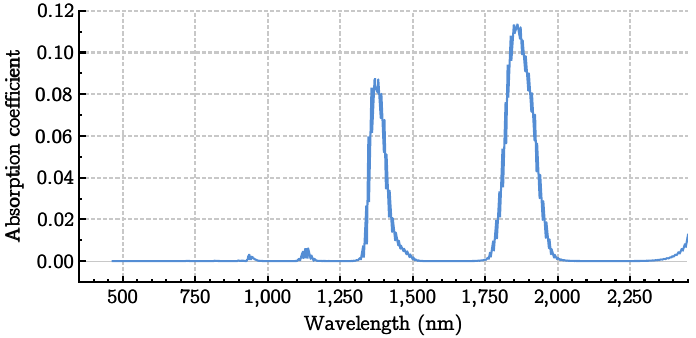
Figure 10. H 2 O absorption spectrum, with a wavelength step greater than 0.5